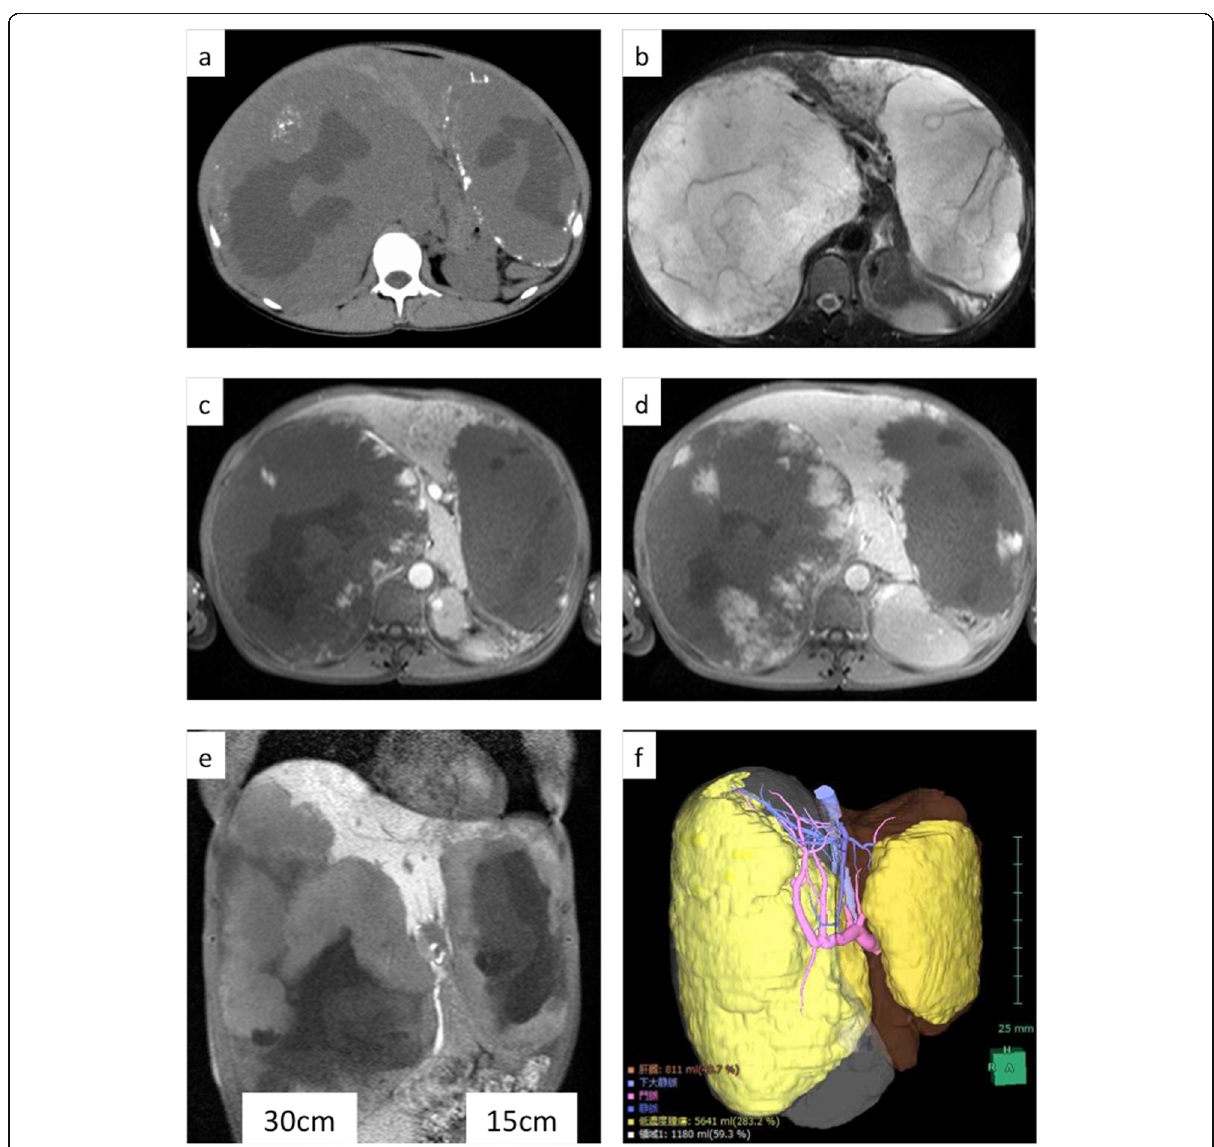
Fig. 1 Plain computed tomography (CT) showed giant liver hemangiomas with lipiodol deposits ( a ). Magnetic resonance imaging (MRI) showed a 30-cm liver hemangioma in the right lobe and 15-cm liver hemangioma in the left lateral section ( b T2 image, c arterial phase, d portal phase, e hepatobiliary image). There is normal liver parenchyma with tiny hemangioma in segment 4. According to 3DCT volumetry, the right liver volume was 60% ( f